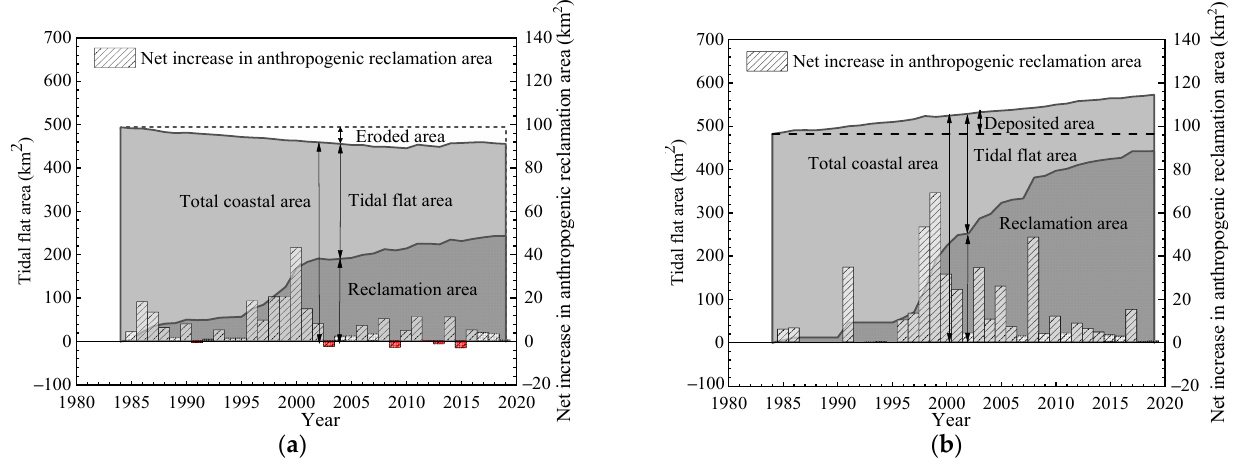
Figure 10. ( a ) The changes of anthropogenic reclamation area in the north erosion part; ( b ) The changes of anthropogenic reclamation area in the south deposition part.